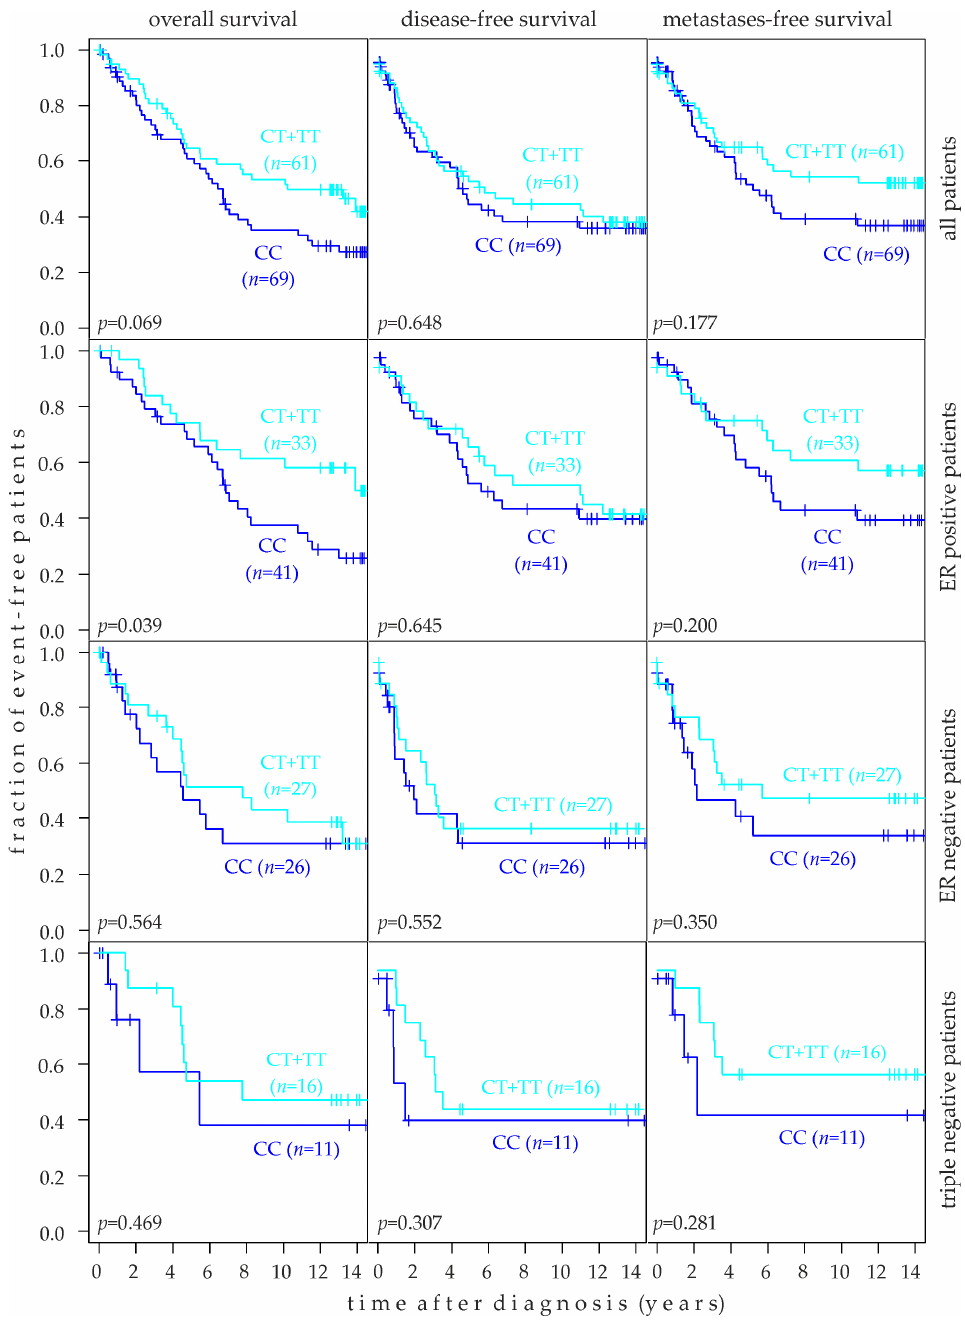
Figure 4. Association of rs10069690 genotypes with the survival of human breast cancer patients. Patients with CT and TT genotypes were combined into one group and compared to CC patients. Kaplan-Meier analyses of the overall survival, disease-free survival, and metastasis-free survival in unselected patients (top row, n = 130), estrogen receptor (ER) positive patients (second row; n = 74), ER-negative patients (third row; n = 53), and triple-negative patients (bottom row; n = 27) are shown. Numbers ( n ) of patients in each group and p -values ( p ) are indicated.